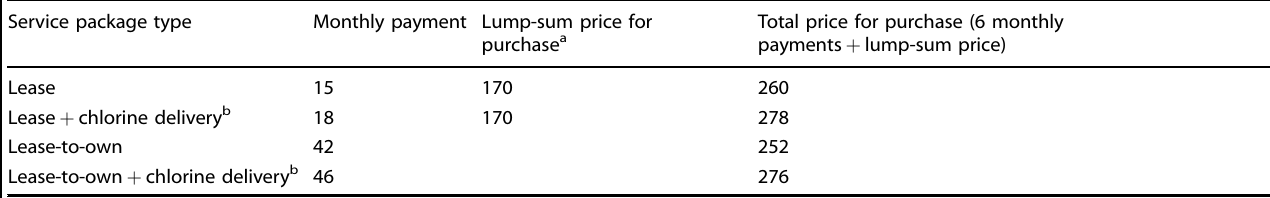
Table 1. Price elements by service package type (in